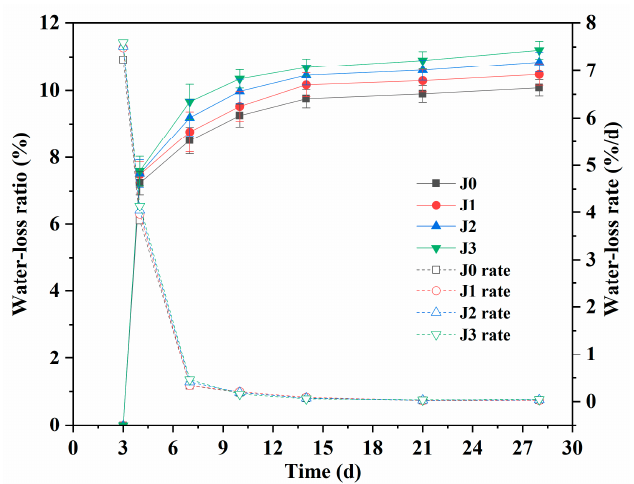
Figure 3. Water-Loss ratio and Water-Loss rate of M-S-H mortar with SRA.